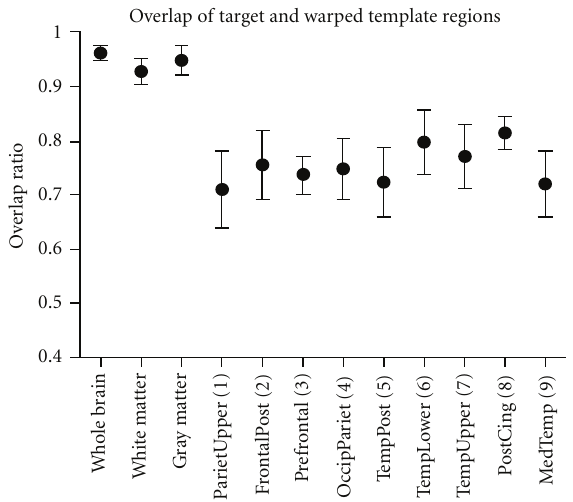
Figure 2: Overlap statistic by region. Data shown is average overlap, ± SD, between common space regions and warped regions of remaining 22 subjects.